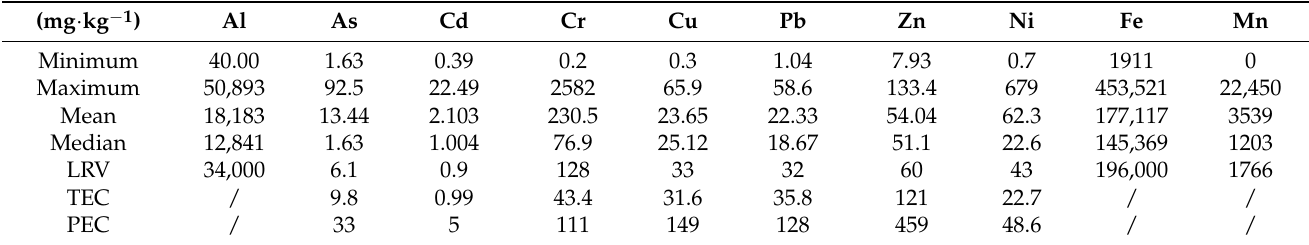
Table 3. Statistical data of metal concentrations in sediments of the Conceiç ã o river basin. Local reference values (LRV) [6] and SQCG values [11].